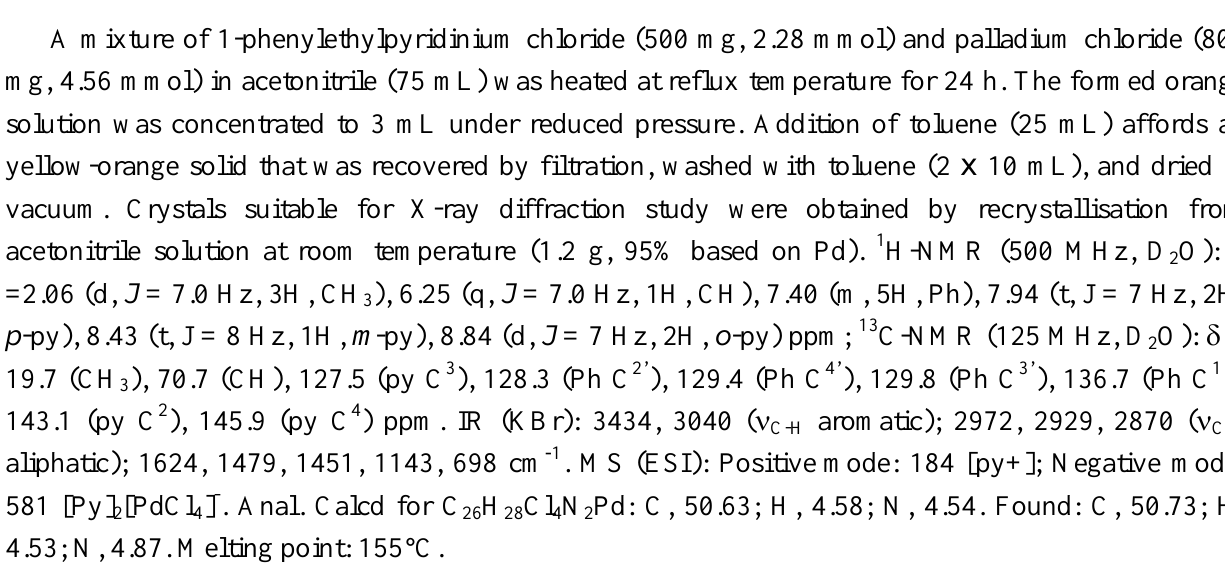
Table 1. Summary of Crystallographic Data and Parameters for [py*][Cl] and for [py*]